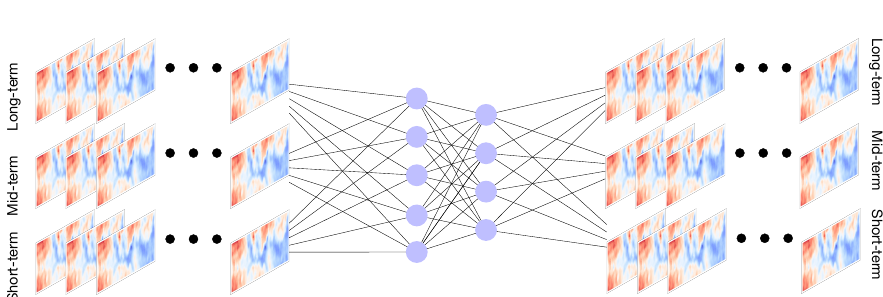
Figure 4. Multi-scale SST prediction that uses different scales, e.g., daily, weekly and monthly, of historical SST data to predict their future records